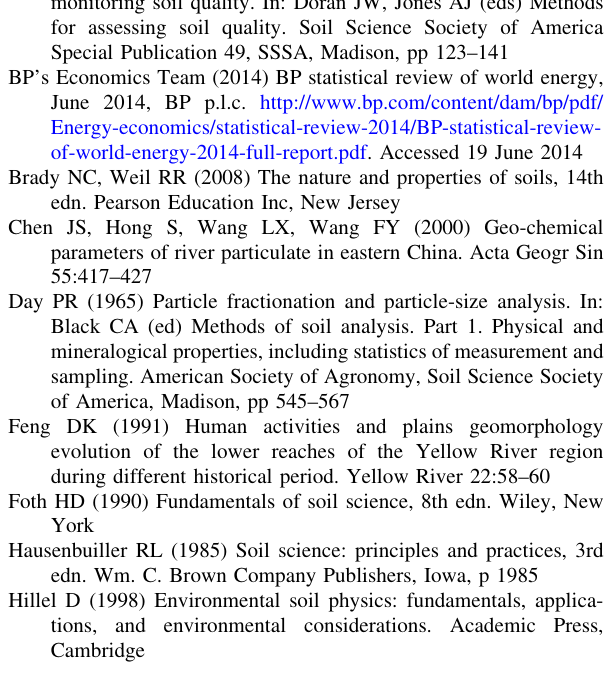
Fig. 5 Wheat growth of the reclaimed and unaltered farmlands. a Reclaimed farmland, b unaltered